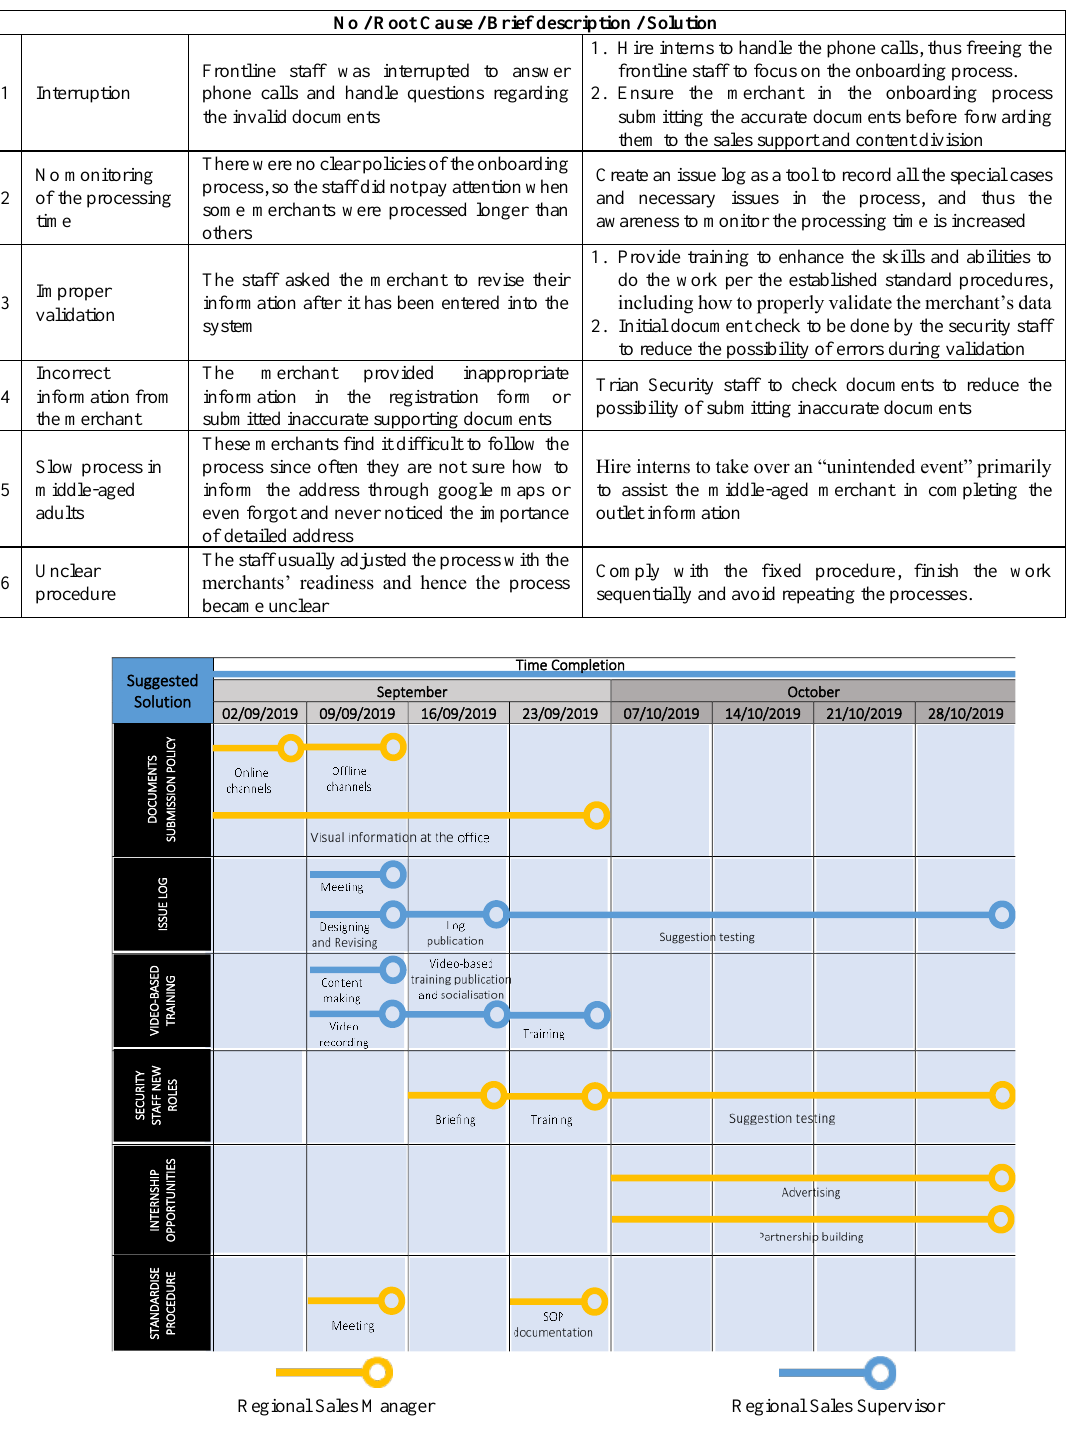
Figure 11. Roadmap